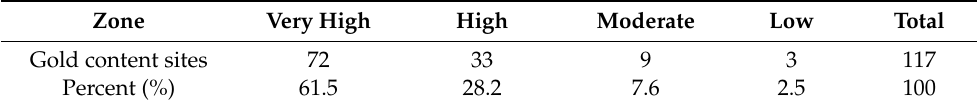
Figure 20. The results of the validation process of the gold mineralization potential zones map. Table 7. The validation gird points to the gold mineralization potential zones